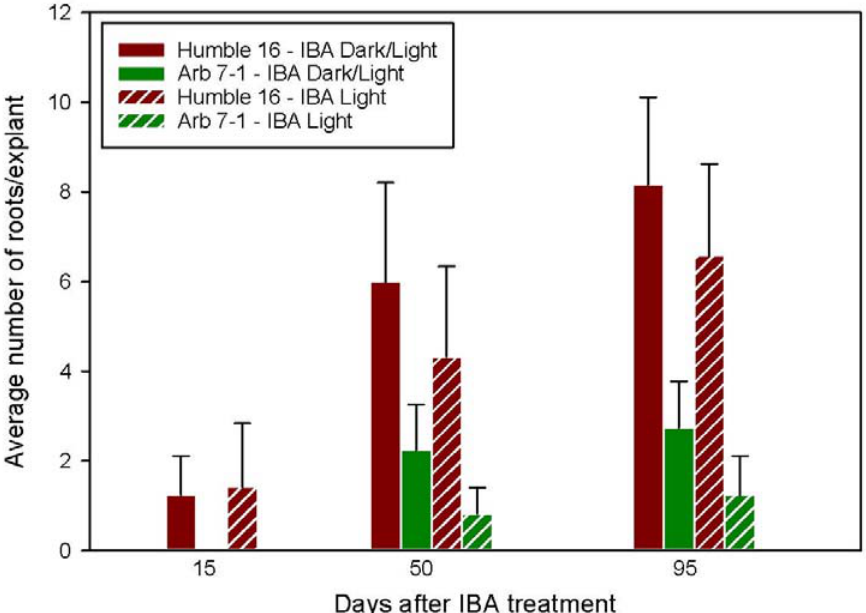
Figure 2. A comparison of the number of roots formed on genotype Humble16 and Arb7-1 after IBA application in “Dark/Light” and “Light” treatments. For each treatment, the total number of roots formed on 12 explants for each genotype and each treatment are reported. Values are means ± standard errors. The difference between light and dark/light treatments at 50 days and at the end of the experiment (95 days) were significant at p < 0.05 using a two ‐ sample Z ‐ test.